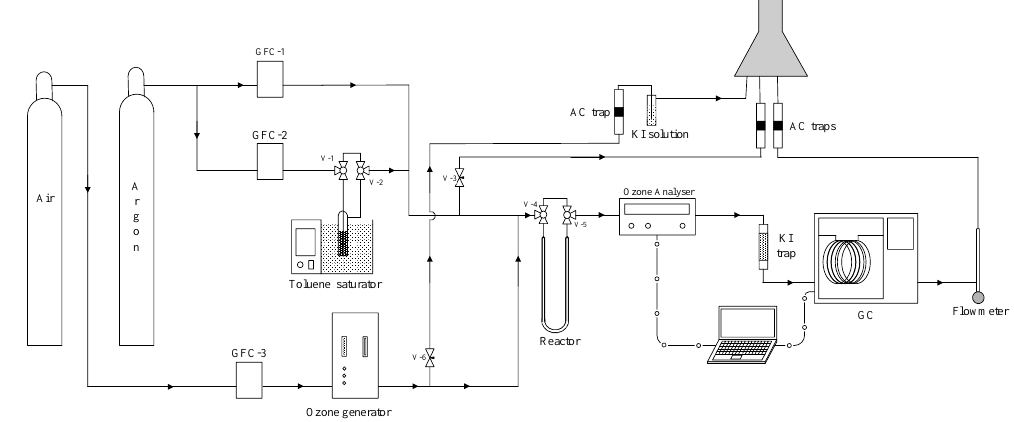
Figure 5. Experimental system of the catalytic ozonation of toluene using natural and modified zeolites.